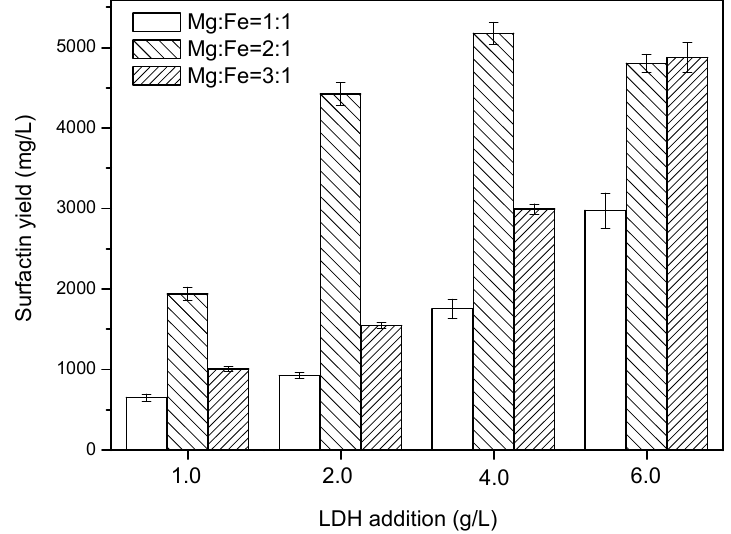
Figure 3. Effect of Mg 2 Fe–LDH concentration (1, 2, 4, and 6 g/L) on the specific surfactin yield, where bars with different patterns represent various Mg 2+ :Fe 3+ ratios: blank, 1:1; back slash, 2:1; slash, 3:1. Error bars indicate standard deviations from three tests.